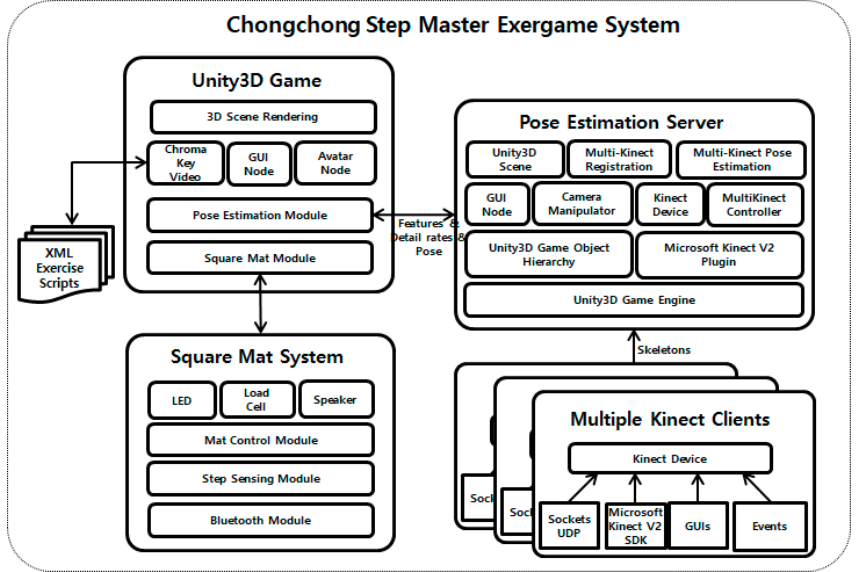
Figure 2. The overall system architecture of the Chongchong Step Master exergame.